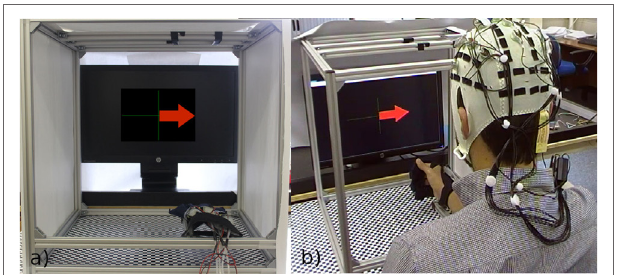
FigUre 5 | (a) The test environment, which is fully enclosed at either side to avoid distraction, and the glove lying on the arm rest, we have overlayed the arrow from the OpenViBE software to show what the subject would see on the screen. (B) A subject performing the initial training phase.